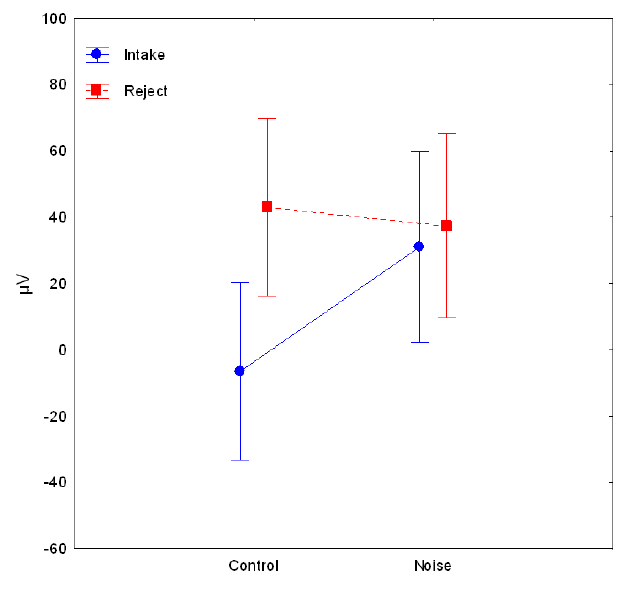
Figure 4. Mean values (±95% CI) of pooled brain DC potentials for intake and rejection tasks in control condition and noise